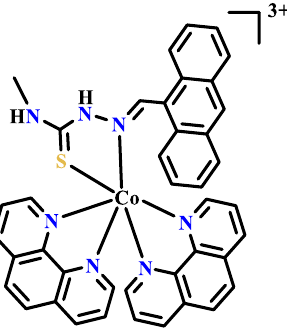
Figure 40. A cobalt(III) complex using the same 9-anthrahydrazone ligand by introducing o -phenanthroline as a co-ligand.